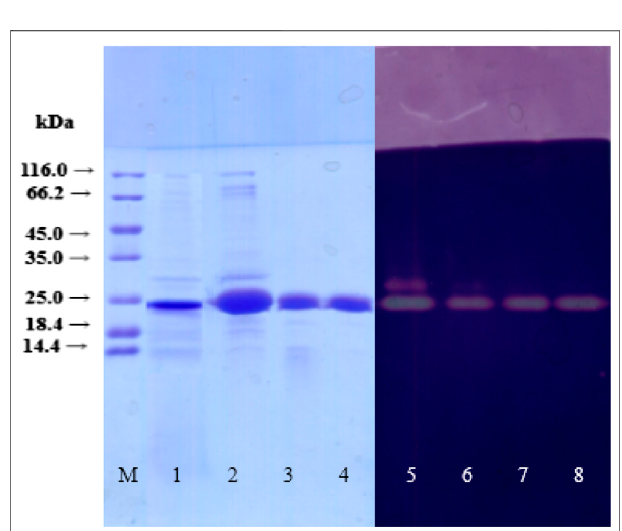
FIGURE1| SDS-PAGEandzymogramofXynBduringpuri fi cation.Lane M, SM031 standard protein marker (14.4 – 116.0 kDa); lane 1, crude extract; lane 2, 50 – 70% ammonium sulfate precipitation; lane 3, a fraction of SP- Sepharose Fast Flow puri fi cation; lane 4, a fraction of Q-Sepharose Fast Flow puri fi cation; lane 5, zymography of crude extract; lane 6, zymography of 50 – 70% ammonium sulfate precipitation; lane 7, zymography of fractions of SP-Sepharose Fast Flow puri fi cation; lane 8, zymography of puri fi ed xylanase of Q-Sepharose Fast Flow puri fi